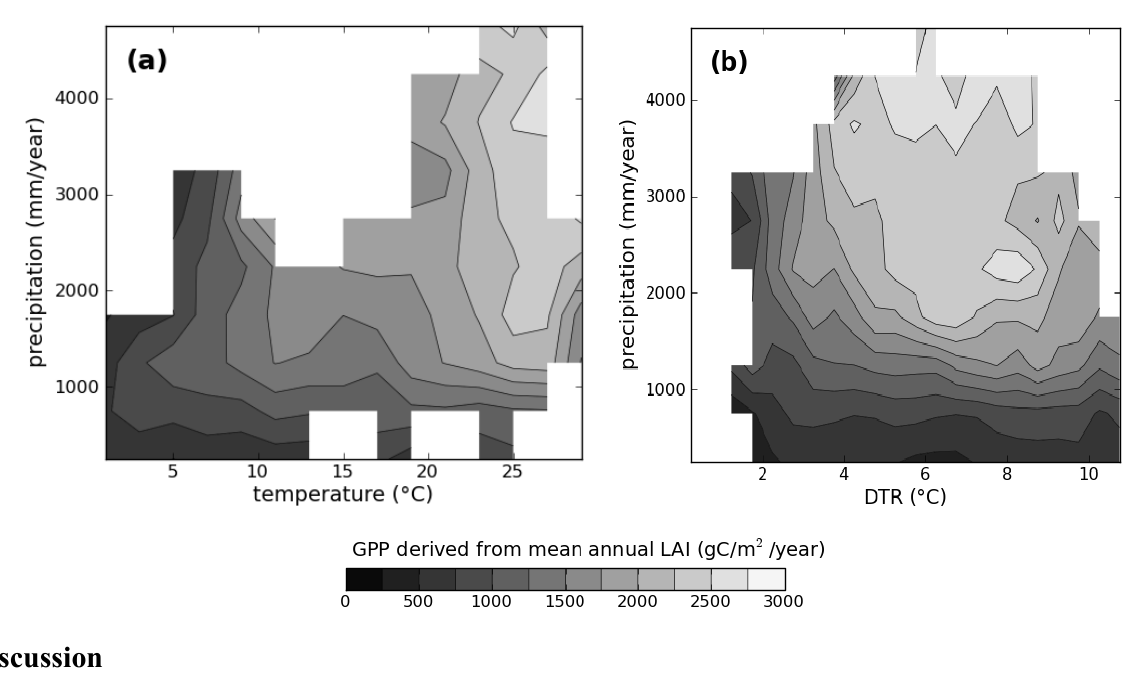
Figure 7. Contour plots of estimated GPP against temperature and precipitation ( a ) and against precipitation and diurnal temperature range (DTR) ( b